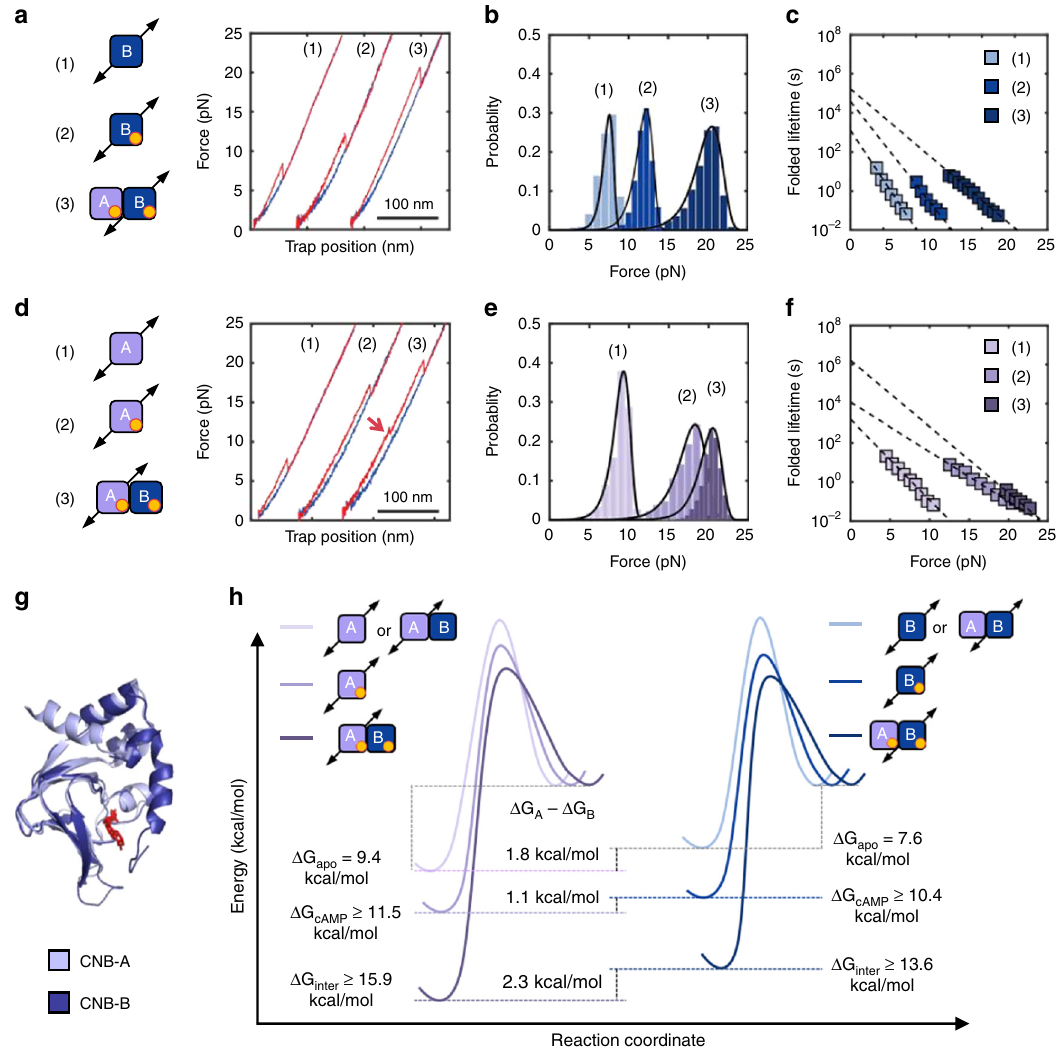
Fig. 2 Selective allosteric effects initiated by cAMP binding. Force-extension curves ( a , d ), unfolding force probability distributions ( b , e ), and force- dependent folded-state lifetimes ( c , f ) for the CNB-B (top) and CNB-A (bottom) domains. Numbering corresponds to the isolated CNB domains in the apo (1) or cAMP-bound states (2), and selective unfolding of the CNB domains bound to cAMP (3). The red arrow in d indicates the unfolding of the N3A motif. Source data for a through d are provided as a Source Data fi le. g Structural alignment of the CNB-A (light purple) and CNB-B (dark blue) domains bound to cAMP (red). h Energy landscape and free energy of the CNB domains due to cAMP binding and inter-domain contacts. The height of the energy barriers re fl ects the folded and unfolded-state lifetimes of the CNB domains in the different states. The energy landscapes have been normalized to the unfolded state. (Supplementary Tables 1 and